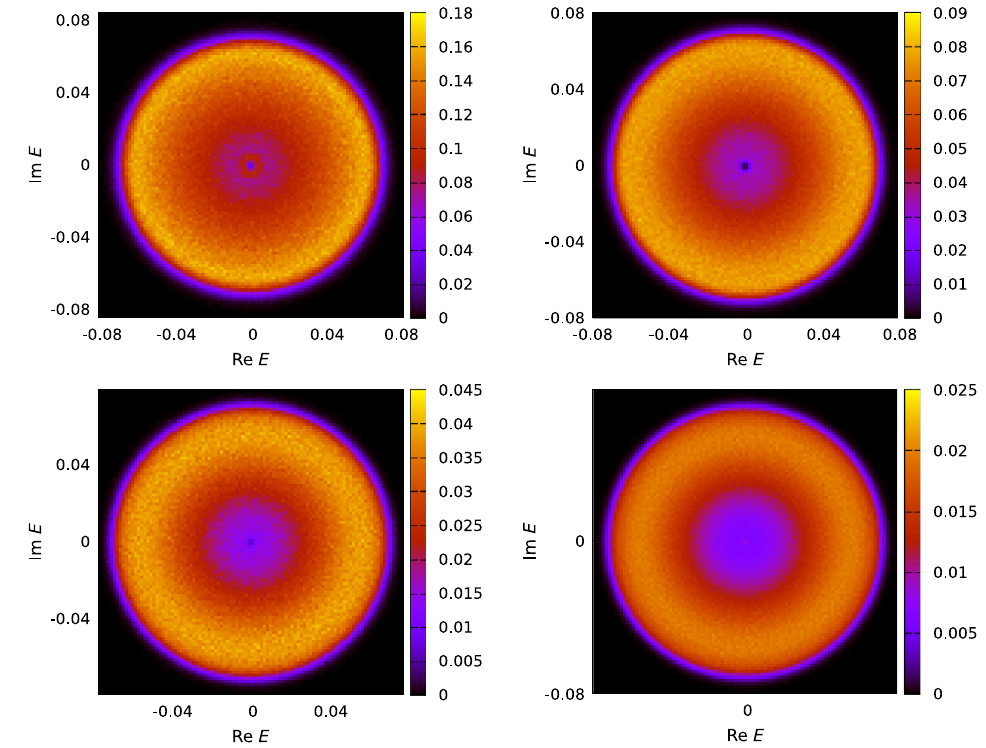
FIG. 2. Spectral density associated with the eigenvalues of the nHSYK Hamiltonian of Eq. (1) for q ¼ 3 and N ¼ 18 (top-left panel), 20 (top-right panel), 22 (bottom-left panel), and 24 (bottom-right panel). The spectral density is radially symmetric but qualitatively different from the q ¼ 2 case. In all cases, the spectrum has a sharp edge that becomes discontinuous in the thermodynamical limit, and the maximum is not at the center but rather in a ring not far from the edge. The chiral symmetry of the spectrum E → − E has a rather profound effect on the density in the region j E j ∼ 0 . We can observe the characteristic oscillations for N ¼ 18 near j E j ¼ 0 . The spectral density is, in general, suppressed in this region, though the suppression strength and pattern are dependent on N . These features are related to different non-Hermitian universality